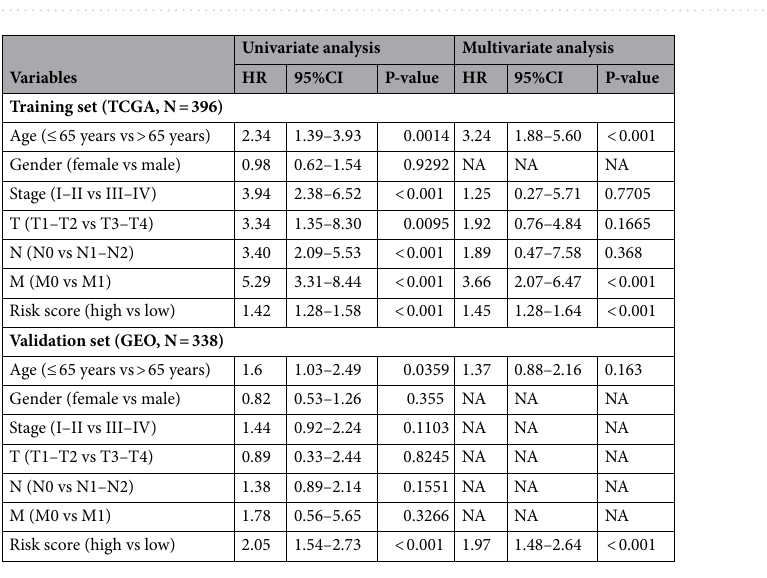
Figure 4. Independent prognostic analysis of 9 DE-DRG signature in the TCGA cohort. (A) Heatmap of the DE-DRGs in prognostic signature for TCGA. (B,C) Forest plot of the association between risk factors and survival of TCGA-CRC by univariate and multivariate Cox regression analysis.